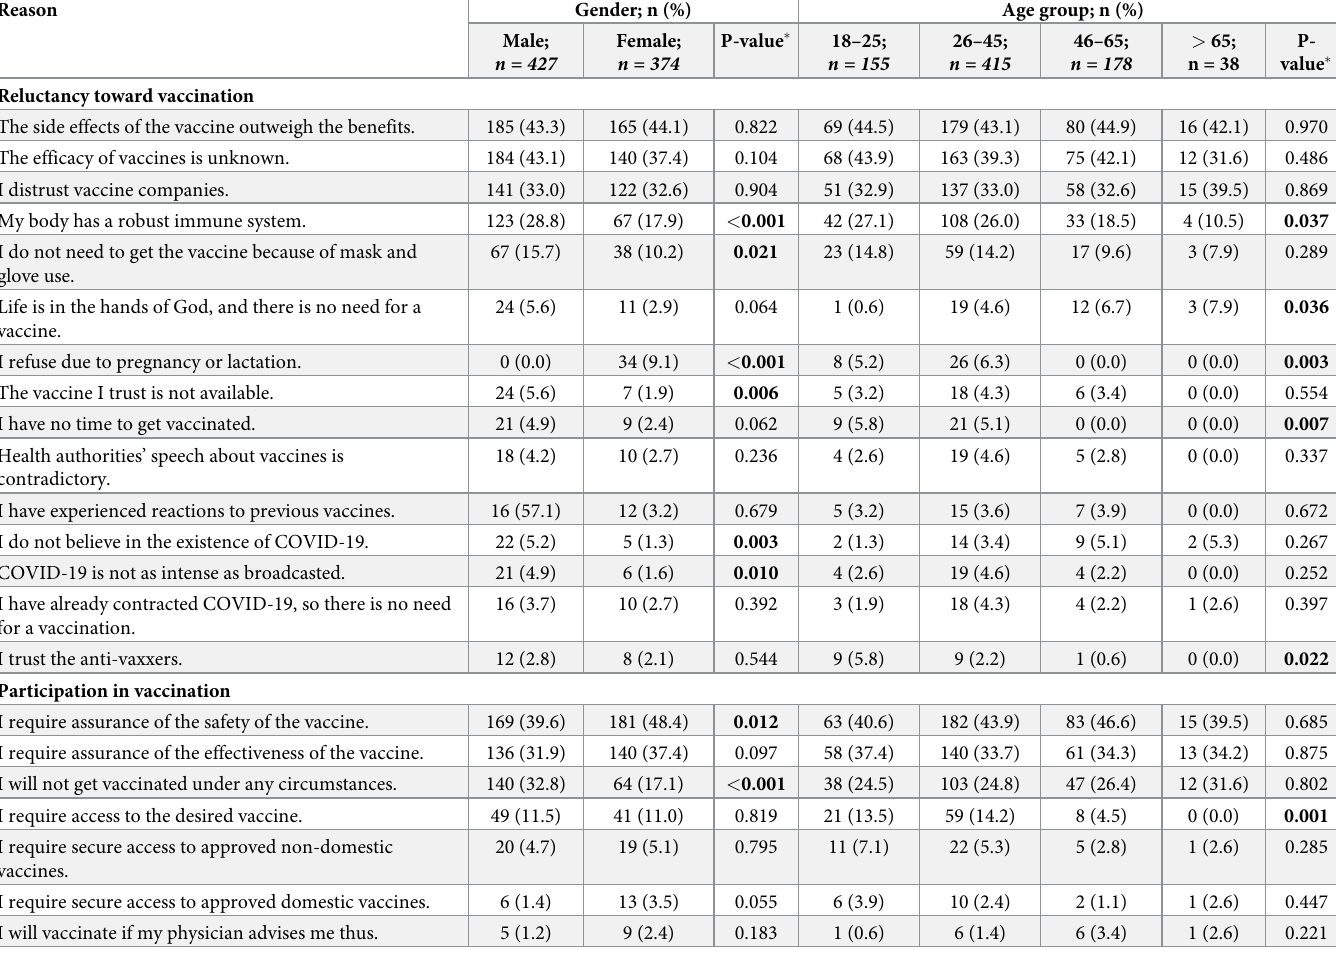
Table 4. Association of age and gender with reluctancy towards coronavirus disease vaccination and the motivation to participate in vaccination among the general population of